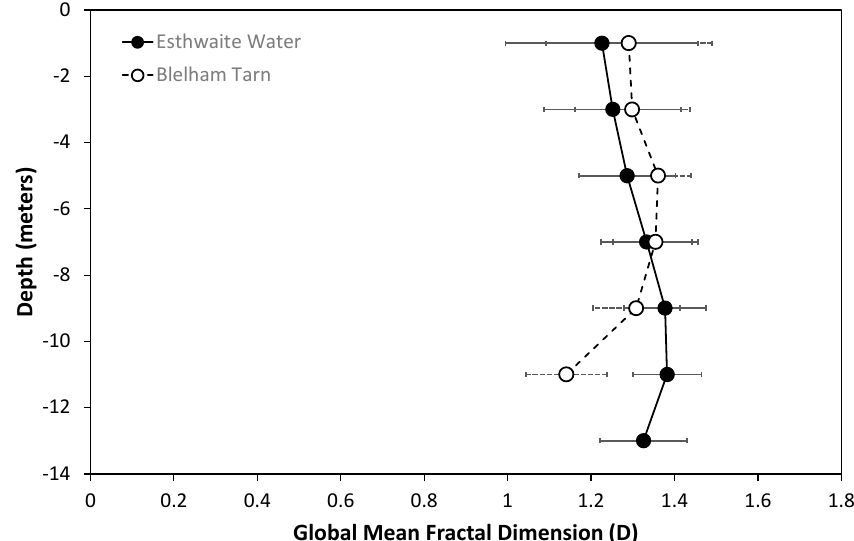
Figure 8. Mean ( ± one standard deviation) values of D in each 2 m-depth bin, averaged over all Figure 8. Mean (± one standard deviation) values of D in each 2 m-depth bin, averaged over all profiles from all dates in each profiles from all dates in each lake.